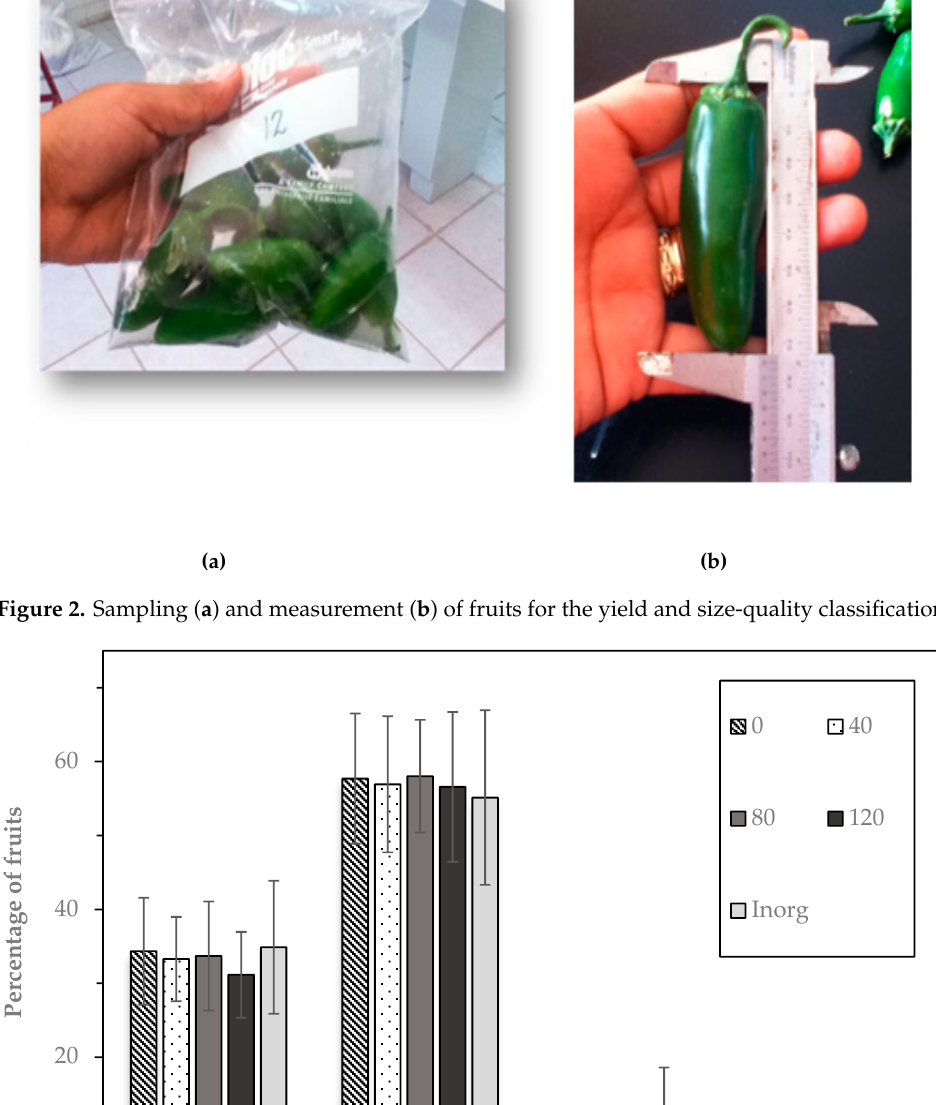
Figure 3. The percentage of the size-class quality of harvested fruits and the differences between the solarized manure treatments.